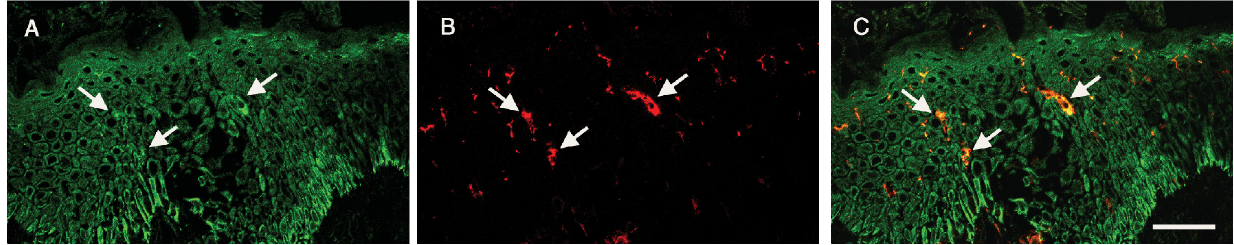
Figure 4. Socs3 is expressed on CD1a + dendritic cells in epidermis. Double immunofluorescensce stainings of lesional AE skin showing (A) expression of Socs3 on keratinocytes and on epidermal dendritic cells, (B) CD1a expression on dendritic cells and (C) co-localisation of Socs3 and CD1a in epidermis. Dendritic cells are indicated by arrows. Scale bar=50 m m.